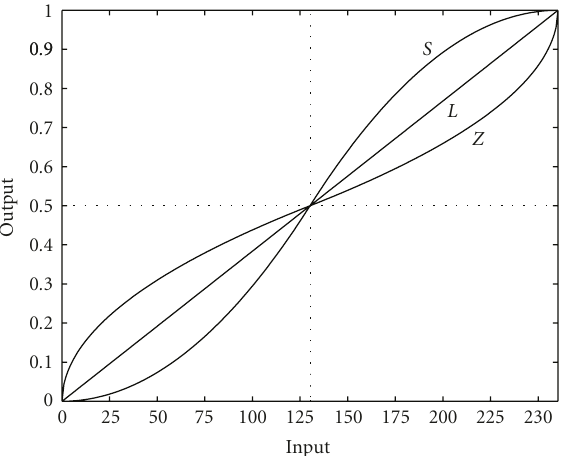
Figure 1: Fuzzification functions: L , S , Z